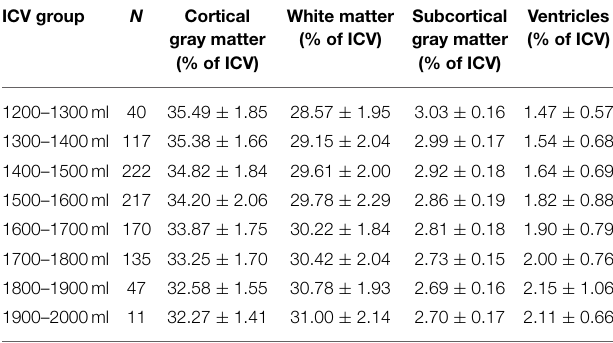
TABLE 2 | Different brain structures expressed as percentage of ICV. ICV